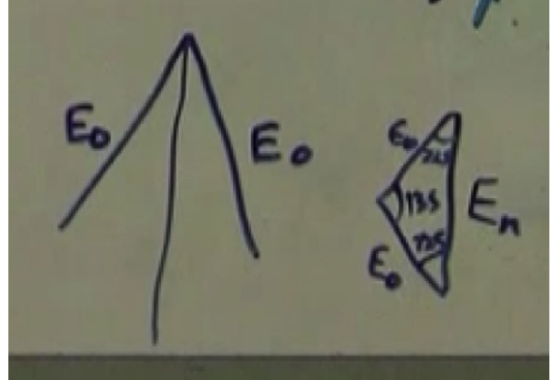
FIG. 6. Detail of Anne ’ s calculation of the net electric field for the lower left region using the vector-arrows representation (without having drawn the arrow heads). The lines labeled “ E ” represent the electric field vectors from each charged plane. 0 The net electric field is represented by the unlabeled line on the leftmost diagram and the line labeled “ E n ” in the rightmost